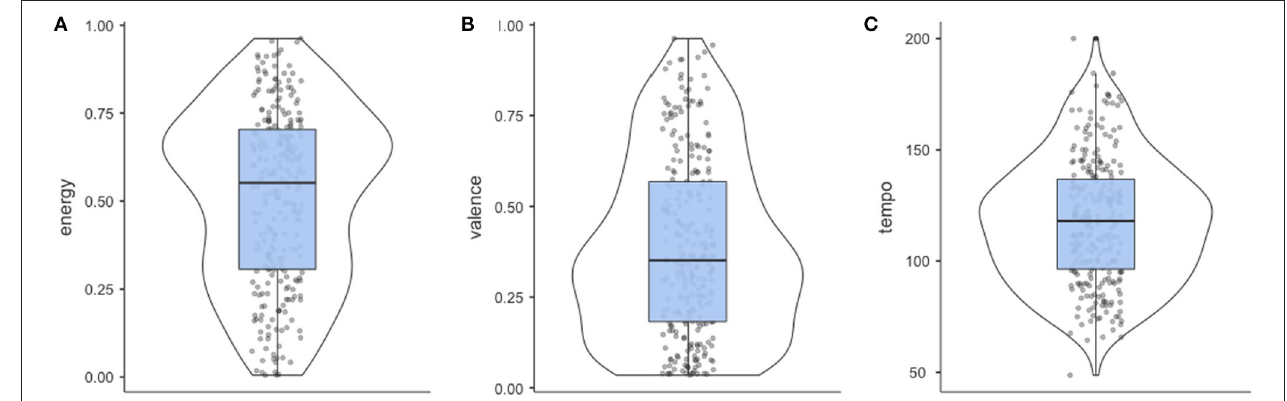
FIGURE 3 | Distribution of continuous audio features for energy (A) , valence (B) , and tempo (C) in 271 songs nominated by University students as helping them cope with COVID-19 stress.